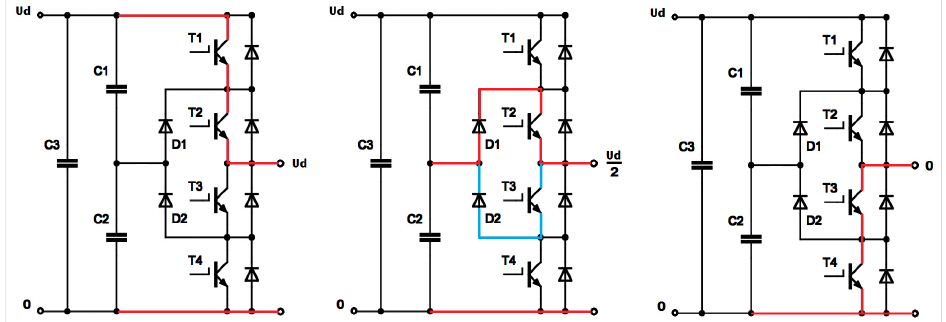
Figure 2. Output voltages of the 3L-NPC inverter: left—U d , center—U d /2, right—0, red line—current flow between capacitor and output terminals, blue line—alternative flow of current for U d /2.